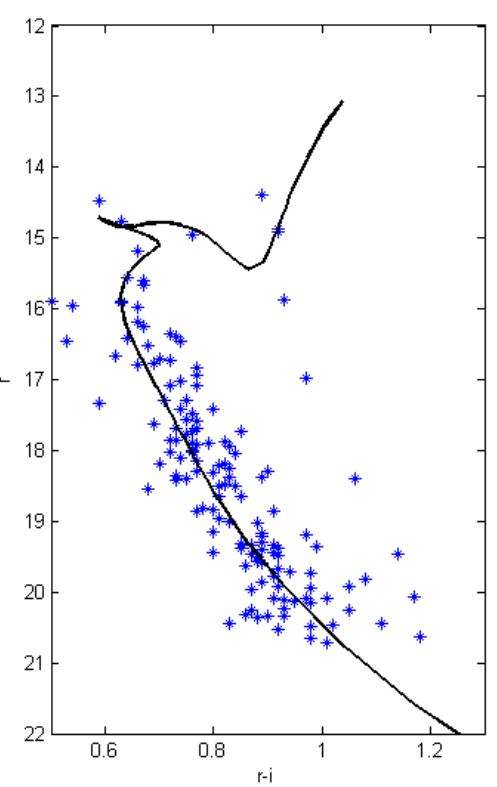
Fig. 4. The ( r , r − i ) diagram for stars within 2 (cid:48) of the center of Czernik 20. The solid line shows the isochrone for the age log t = 9 .